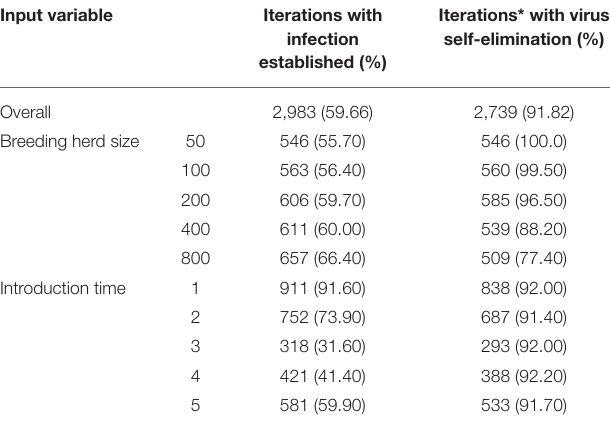
TABLE 4 | Characteristics of BVDV transmission for a single PI introduction (Scenario 1) in a simulated beef